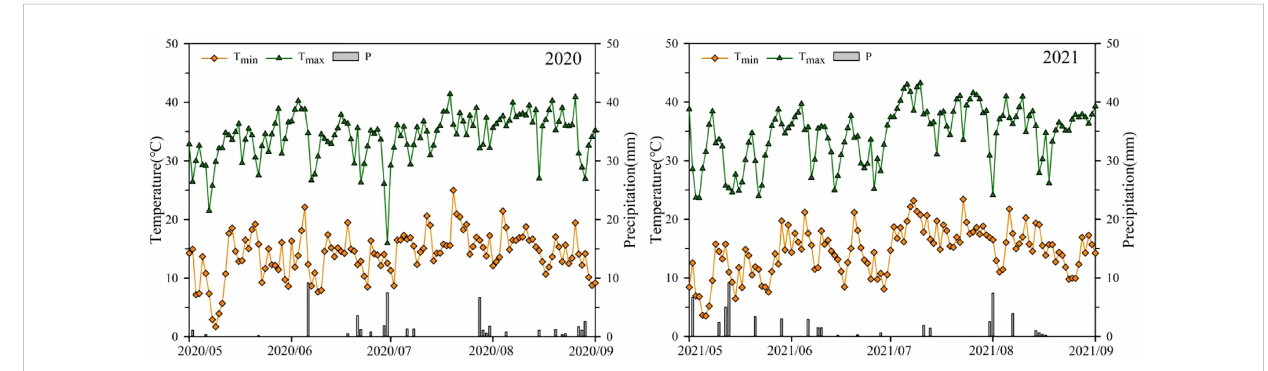
FIGURE 1 Temperature and precipitation in the test area during the rice growth periods of 2020 and